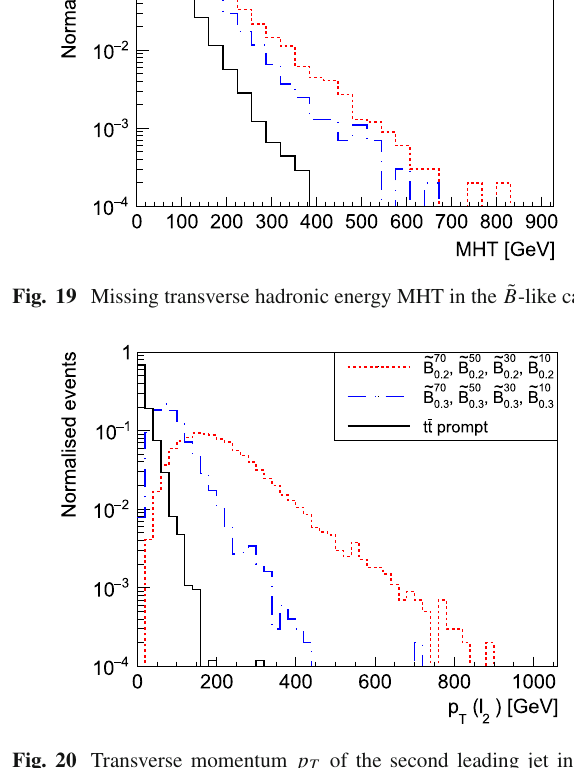
Fig. 20 Transverse momentum p T of the second leading jet in the ˜ B -like case = 400 GeV case stands out with sented in Fig. 27. The m ˜ χ 0 1 = 200 GeV, the a mean value of 710 GeV whereas at m ˜ χ 0 1 THT distribution is close to the prompt t ¯ t one. One main difference with the bino-like process is the num- ber of events with at least one top quark decaying inside the “tracker volume” (see R ≥ 1 displaced t observable in Table 4). For (cid:3) d flight ˜